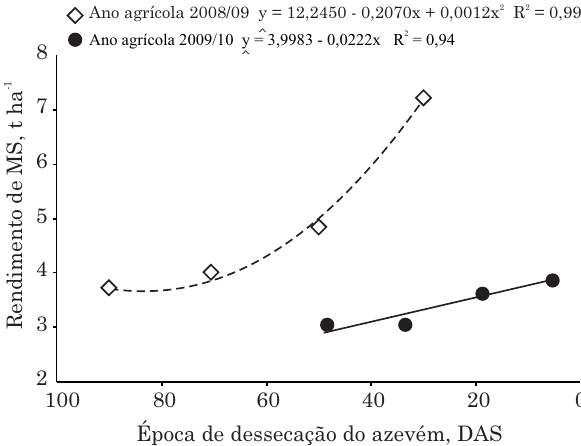
Figura 2. Rendimento de matéria seca (MS) da parte aérea de azevém em razão da época de dessecação, em dois anos agrícolas. DAS: dias antes da semeadura do arroz em